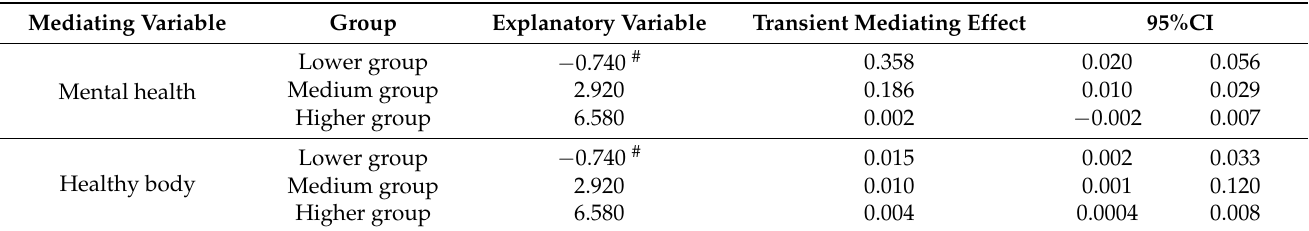
Table 3. Estimation of the effect of physical and mental health as an intermediary factor in the impact of physical activity duration on academic